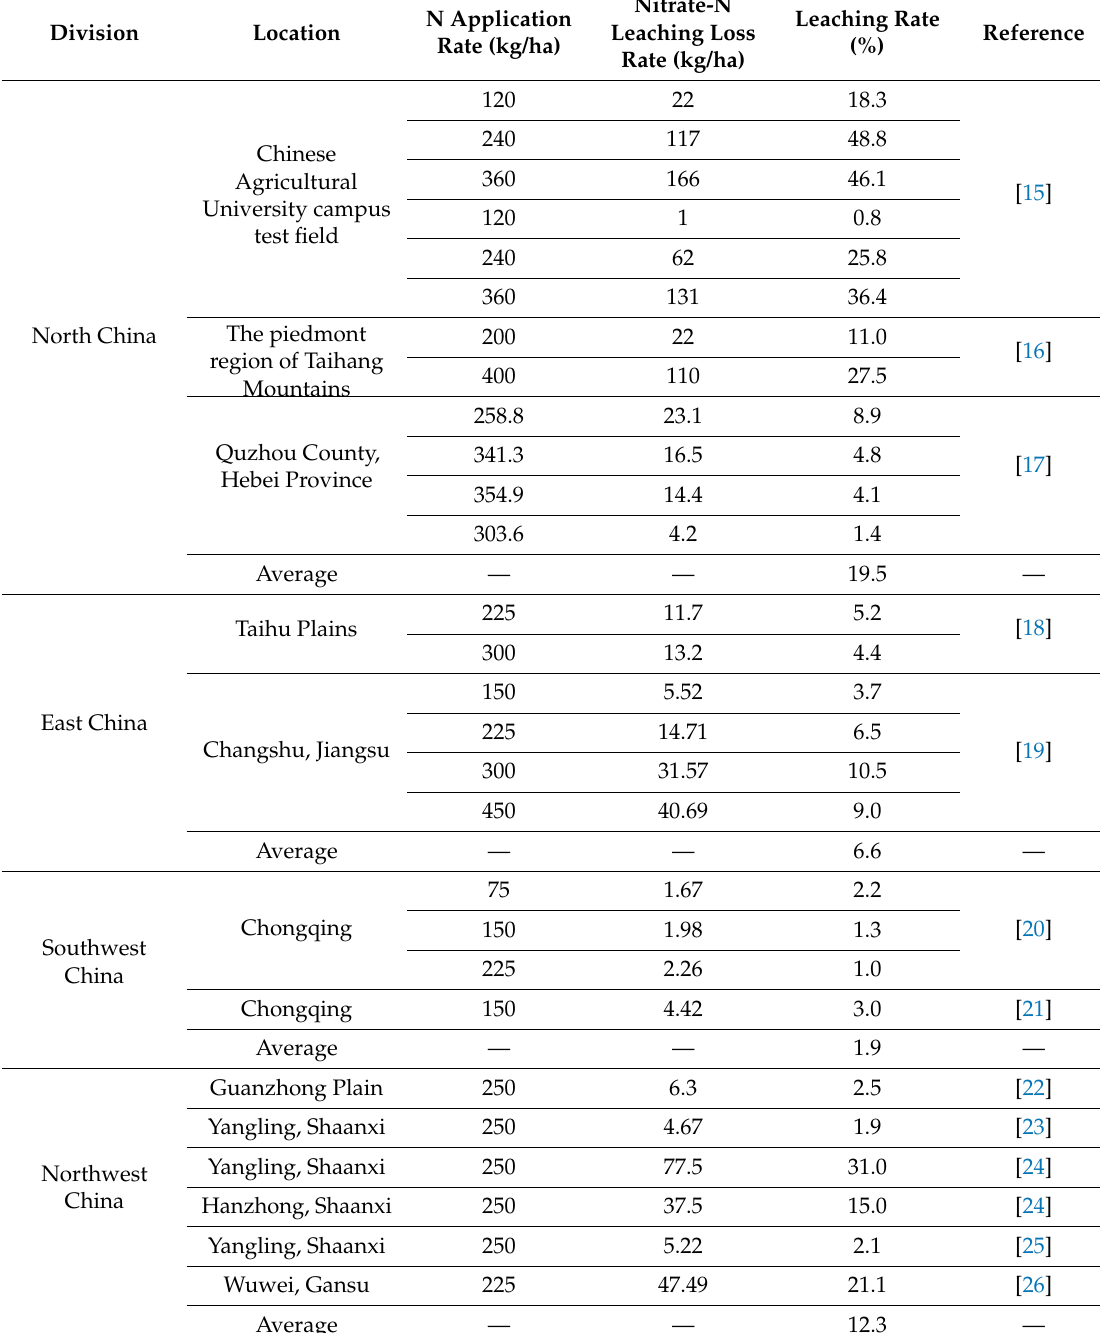
Table 1. Nitrogen application rate and nitrate-nitrogen leaching rate in key wheat cultivation divisions.